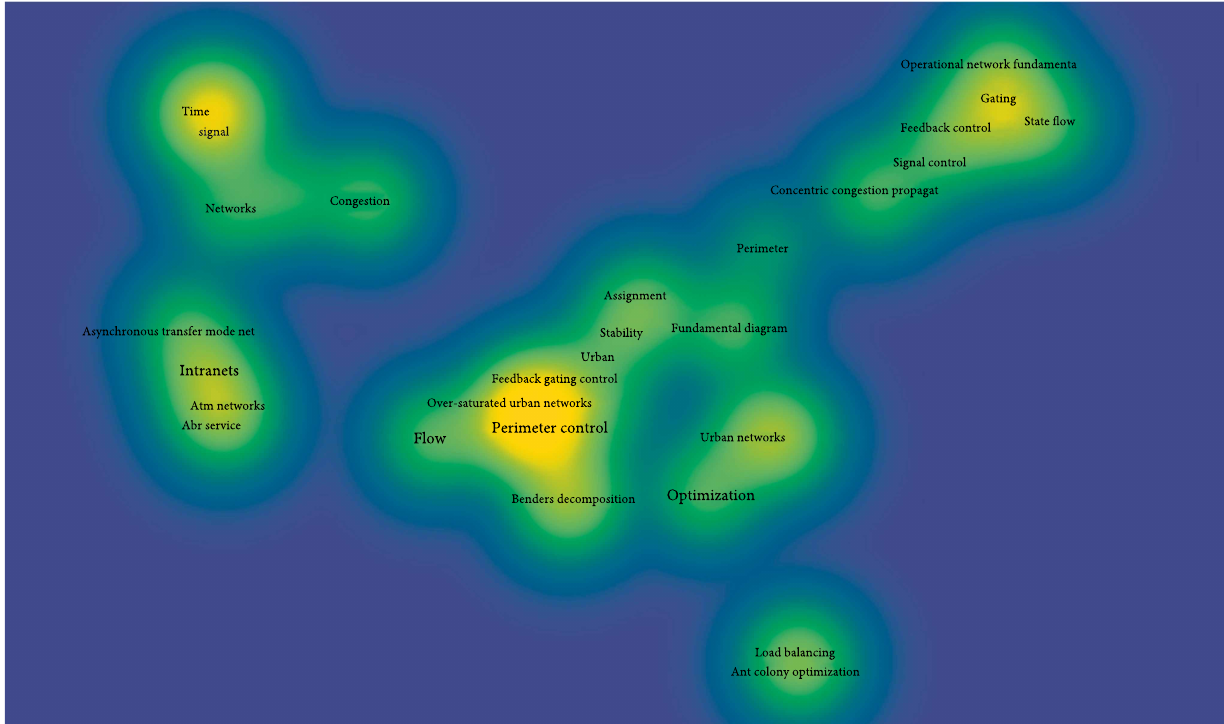
Figure 2: Visualization of gating control in traffic congestion